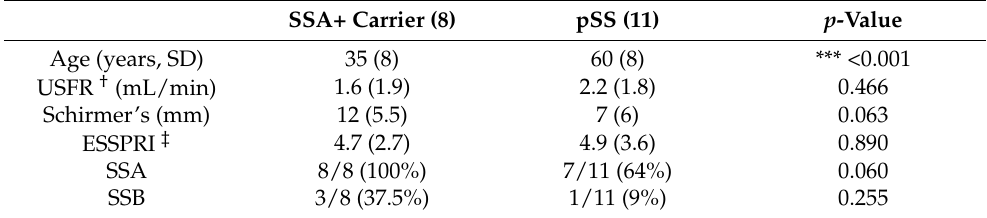
Table 1. Characteristics of the patients who presented a positive result for anti-Ro/SSA antibodies but had no sicca symptoms (SSA+ carrier) and primary Sjögren’s syndrome (pSS) patients. Continuous variables are presented as mean ± standard deviation (SD), while categorical variables as numbers and relative percentages.